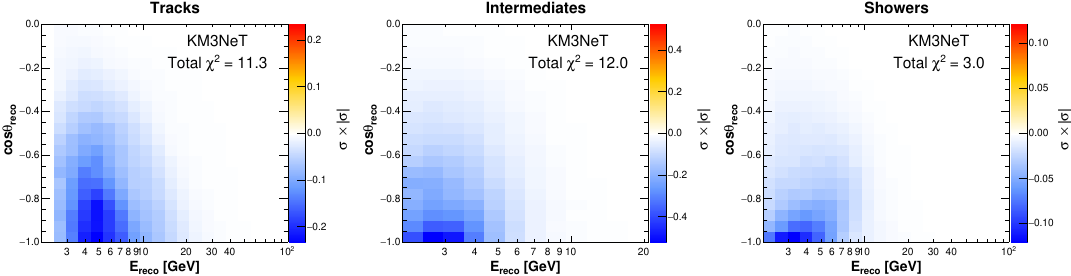
Figure 4. Statistical signed- χ 2 distributions comparing standard oscillations to neutrino decay with α 3 = 10 − 5 eV 2 for 1 year of data taking in KM3NeT/ORCA assuming NO as a function of reconstructed energy and reconstructed cosine of the zenith angle for track events (left), intermediate events (middle) and shower events (right). Note the different